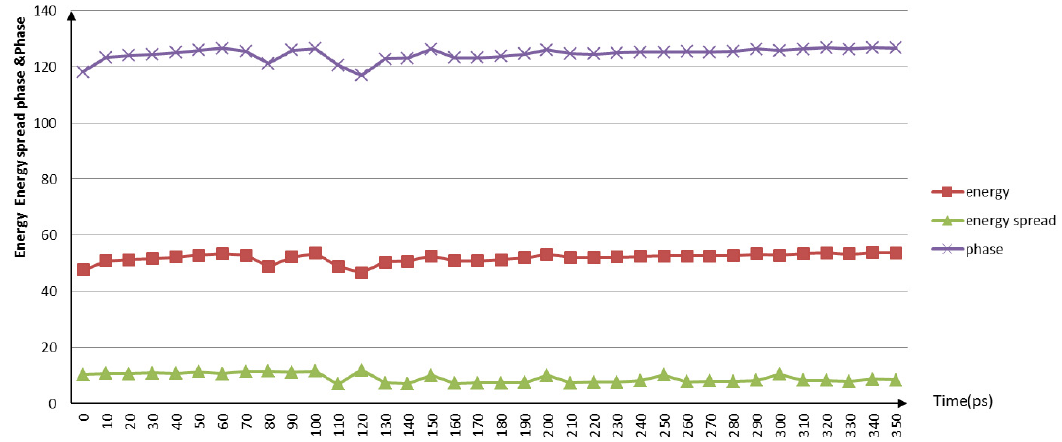
Figure 9. Variations in the beam energy, energy spread, and phase as a function of the gun timing.